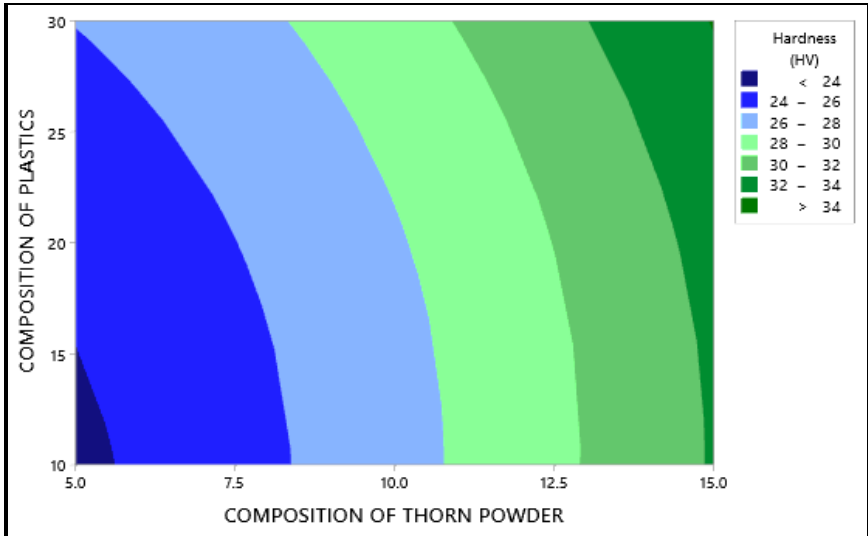
Figure 3. Contour plot for Maximum Hardness.